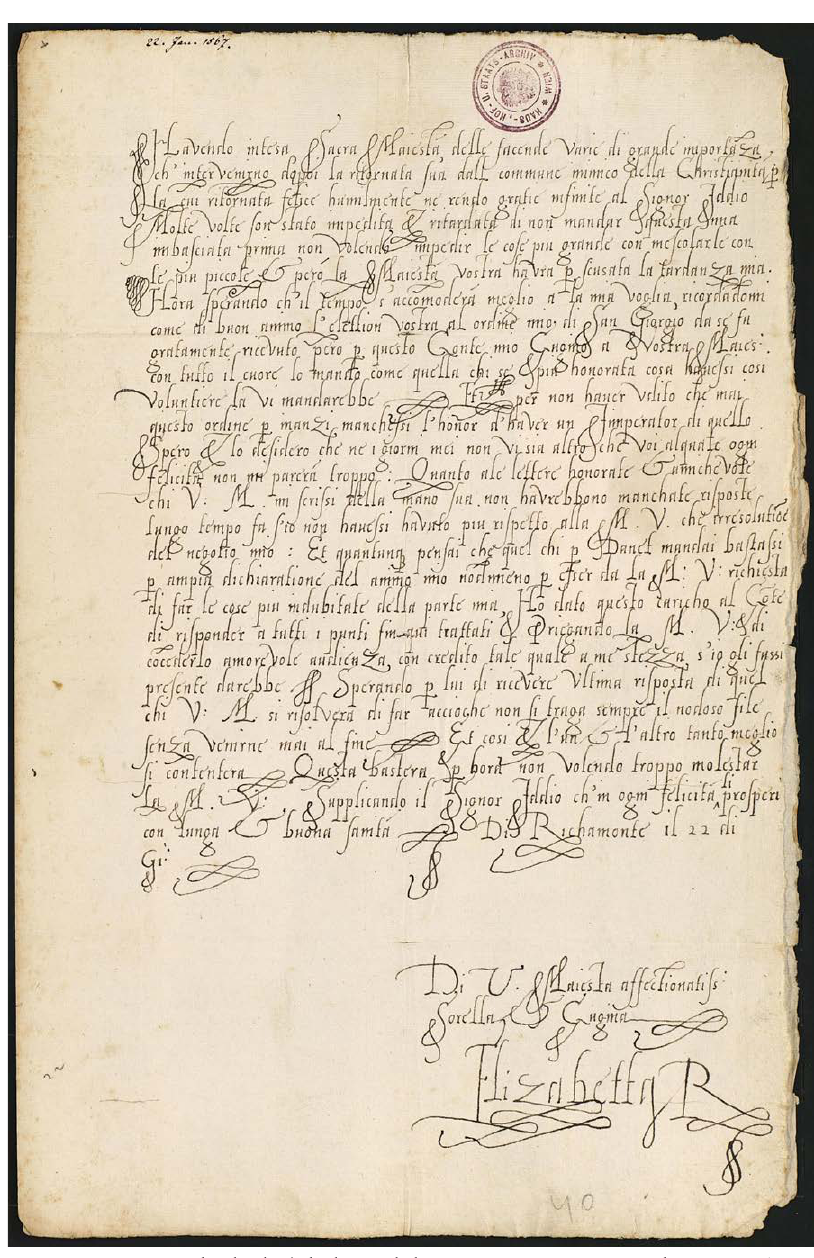
Fig.1 – Queen Elizabeth I’s holograph letter to Emperor Maximilian II, 1567 (reproduced by permission of the Österreichisches Staatsarchiv,